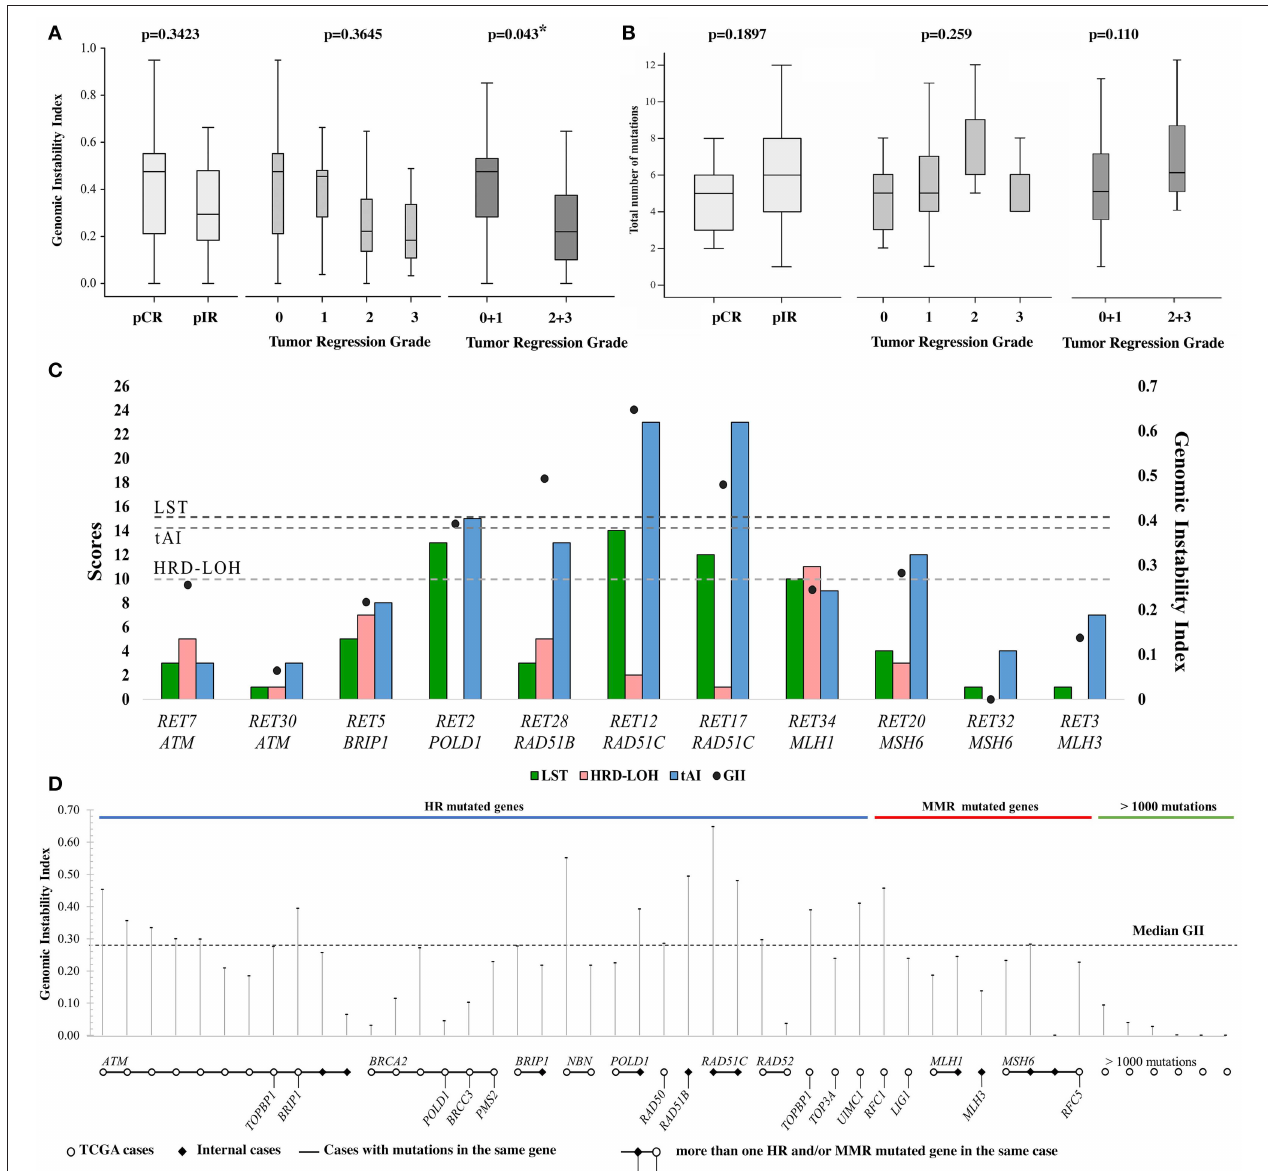
FIGURE 1 | (A) Distribution of the Genomic Instability Index (GII) and (B) the number of mutations found in rectal cancer samples according to pathological response (pCR: complete response or pIR: incomplete) to neoadjuvant chemoradiotherapy. Cases were also categorized into tumor regression grade (TRG) and grouped in TRG 0 + 1 and TRG 2 + 3. (C) Homologous recombination deficiency scores (LST, LOH, and tAI) and GII of samples with mutation in DNA repair genes. (D) GII of each TCGA and internal cases carrying mutation in DNA damage repair pathways (homologous recombination and mismatch repair) genes. Samples carrying mutation in the same gene are shown connected by a line, additional genes are shown below each sample. Samples with > 1000 mutations are indicated, and specific genes were not taken into consideration for these cases. Five of 14 cases from TCGA with mutation in ATM presented > 1000 mutations, and nine of them are represented.